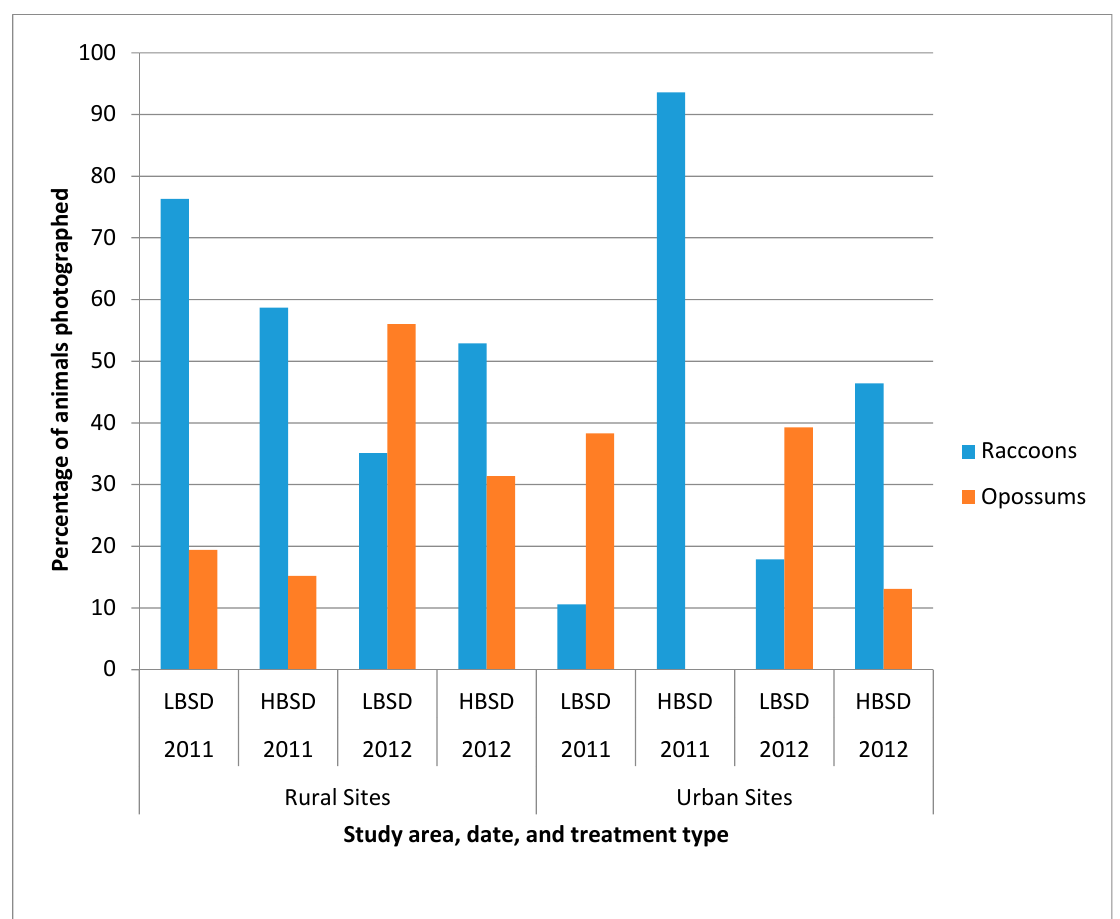
Figure 3. Comparison of raccoon and non-target opossum ratios in automatic camera images at LBSD and HBSD sites in rural and urban environments in Pasco and Pinellas Counties, Florida, during 2011–2012.